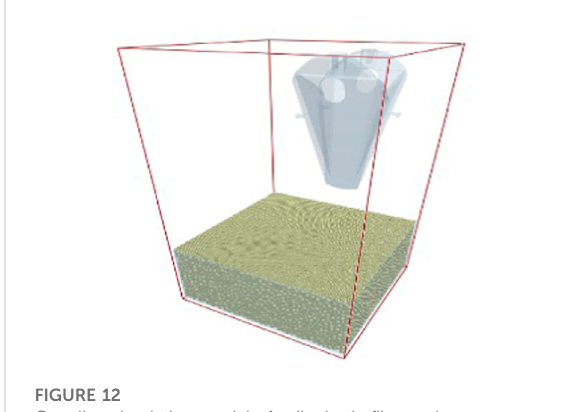
FIGURE 12 Coupling simulation model of soil, plastic fi lm, and hanging cup.